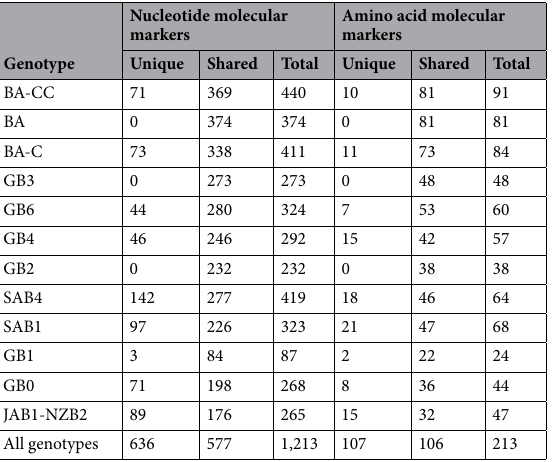
Table 1. Number of unique and shared nucleotide and amino acid molecular markers identified in each RSV-B genotype.